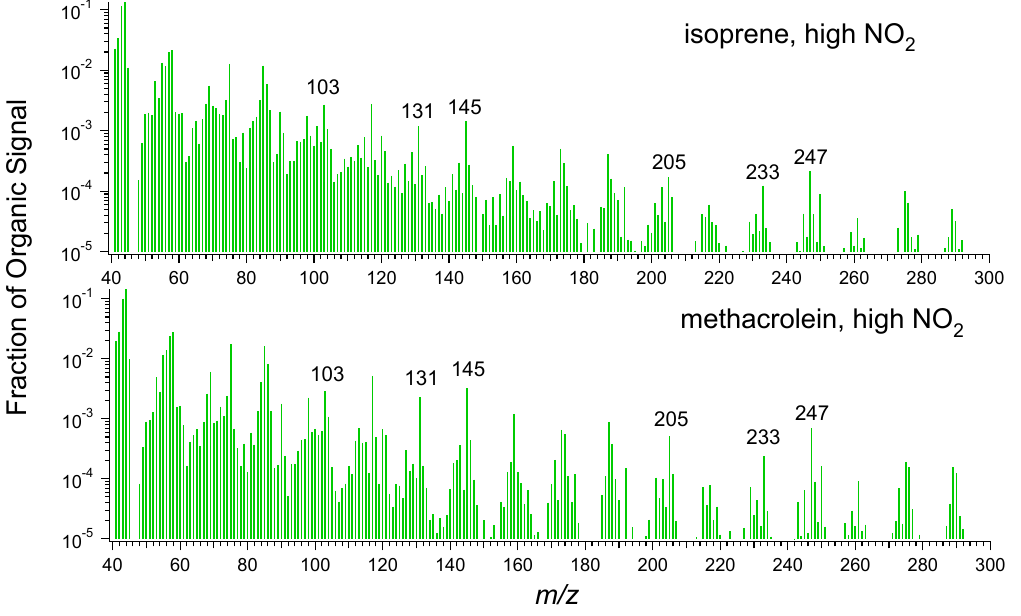
Fig. 8. AMS V-mode organic spectra of SOA from high-NO 2 photooxidation of isoprene and methacrolein. The labelled ion peaks differ from compounds listed in Table 3 by an O 2 − group. The accurate masses are confirmed by W-mode high-resolution analysis, as shown in Fig. 9. Separation of 102Da between major peaks is consistent with esterification with a 2-MG